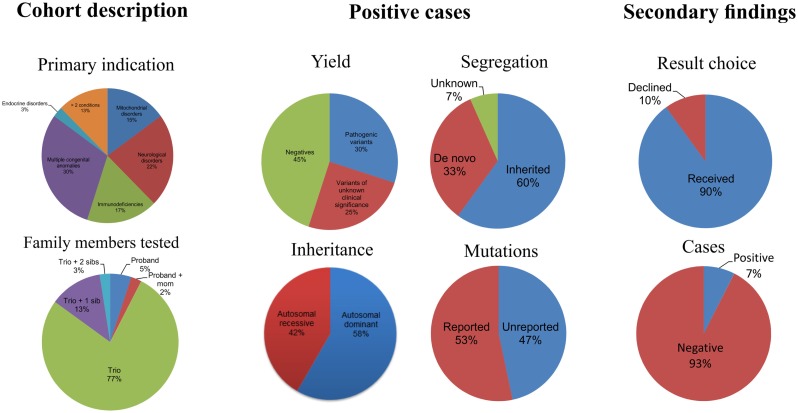
Descriptive statistics of the patient cohort and the positive exome cases.